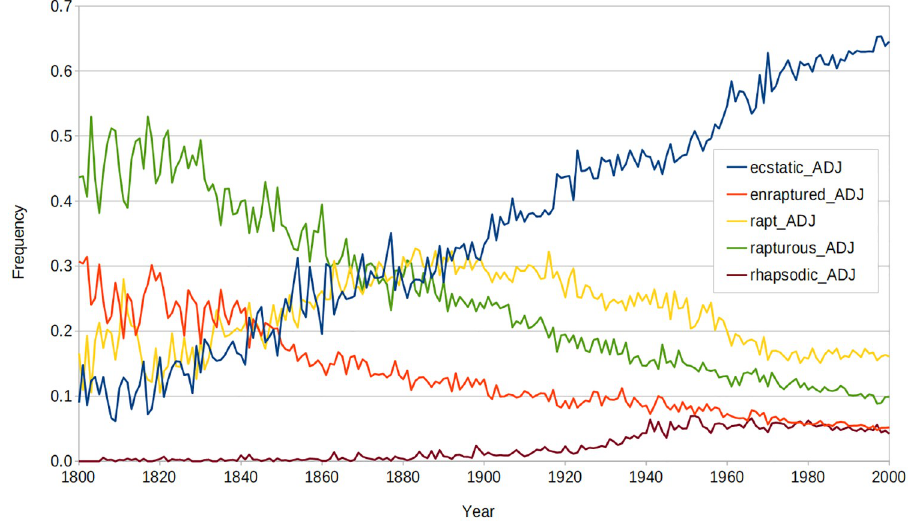
Fig 1. The normalized frequencies of the rapturous–ecstatic synset from 1800 AD to 2000 AD. The sum of the five frequencies for any given year is 1.0. The data has not been smoothed, in order to show the level of noise in the trends. This synset is typical with respect to the shapes of the curves and the level of noise in the trends, but it is atypical in that it contains more words than most of the synsets. Most of the synsets contain two to three words.